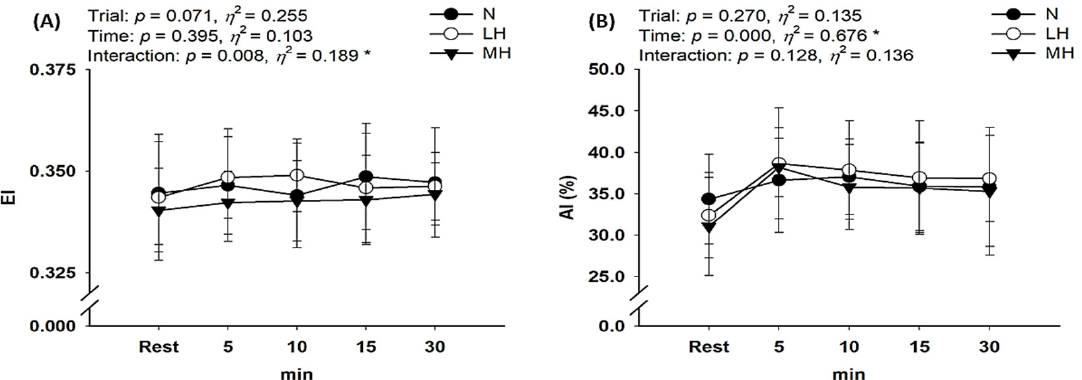
Figure 5. Changes in hemorheological properties at rest and during endurance submaximal exer- cise. ( A ) Erythrocyte deformability (EI) and ( B ) Erythrocyte aggregation (AI). EI: elongation index; AI: aggregation index; N: endurance submaximal exercise under normoxia; LH: endurance submax- imal exercise under light hypoxia (596 mmHg, simulated 2000 m); MH: endurance submaximal ex- ercise under moderate hypoxia (526 mmHg, simulated 3000 m). The bars indicate the mean ± S.D. *: Significant interaction or main effect; a: significant difference vs. normoxia; b: significant difference vs. light hypoxia.